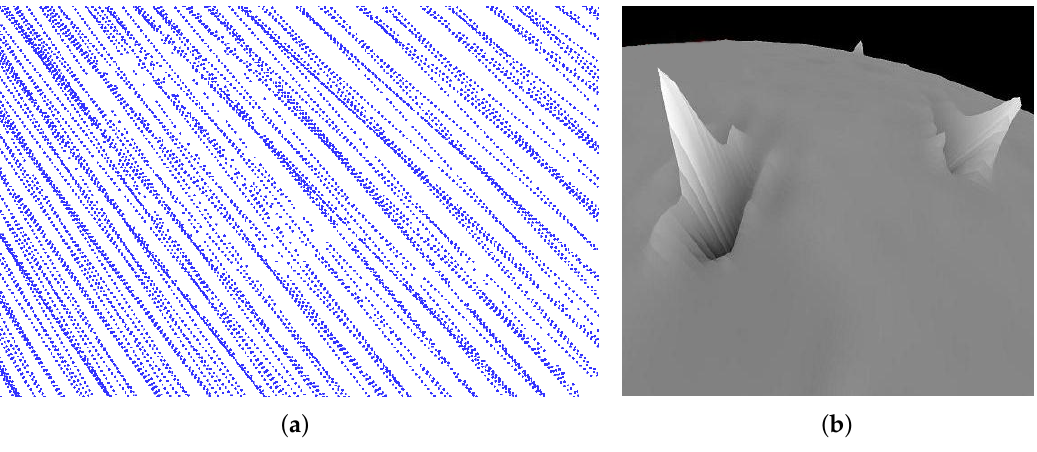
Figure 2. Laser altimeter measurements (LAM) data from Chang’E-1. ( a ) The non-uniform distribution of LAM data; ( b ) the noises in LAM data cause the sudden peaks in the